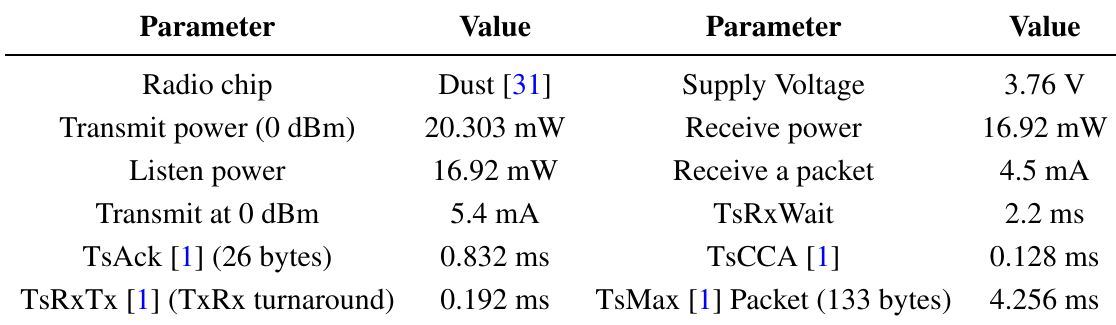
Table 4. Energy-consumption